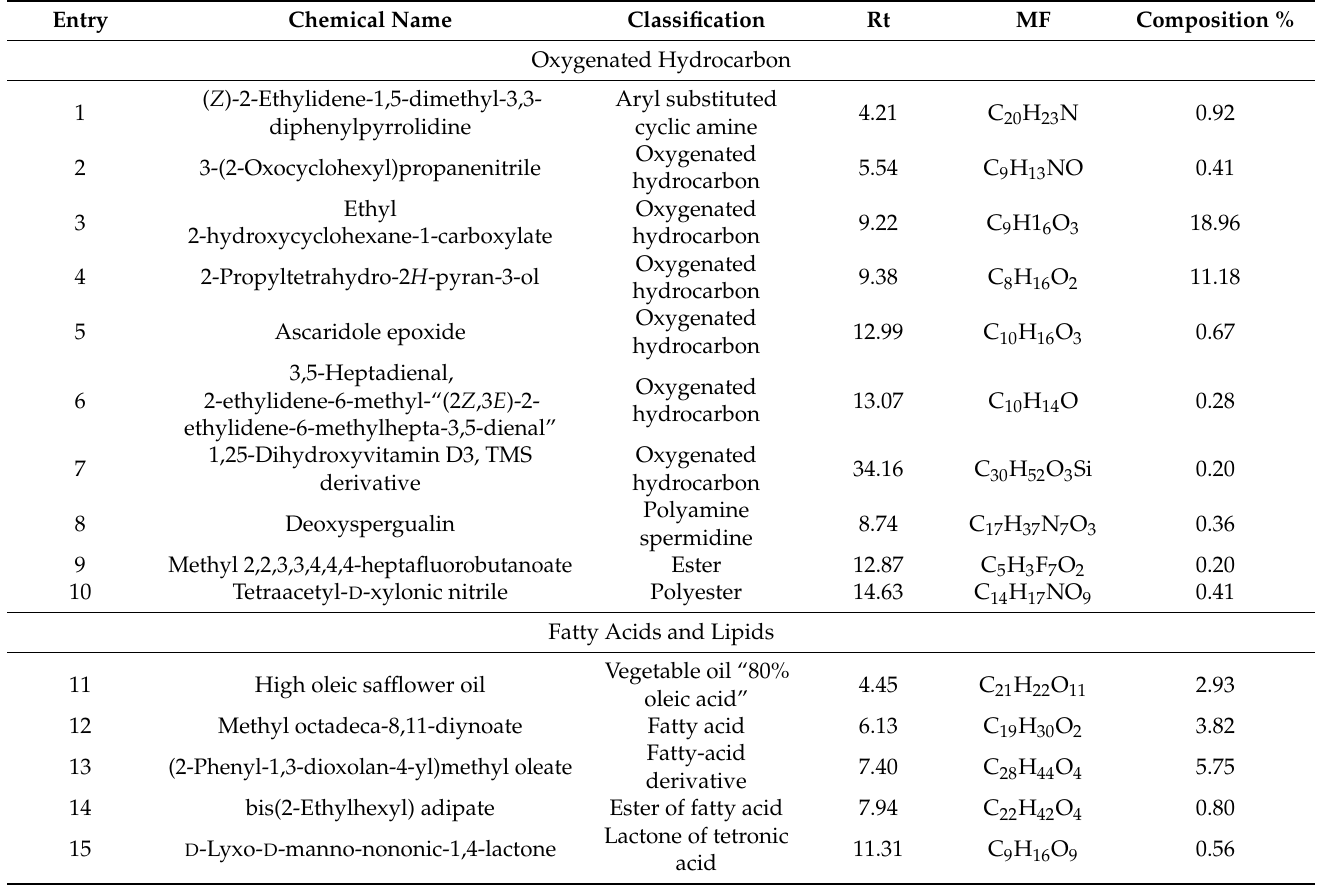
Figure 1. Chromatogram and structures of main components of the methanol extract of Rumex vesicarius shoot by GC–MS. Table 1. The characterized chemical components isolated from the extracted shoots of Rumex vesicarius.